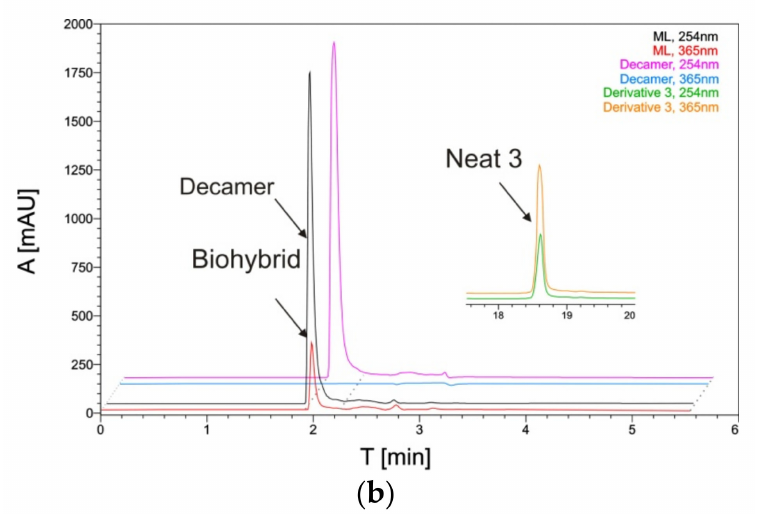
Figure 6. ( a ) The part of the DOSY spectrum of a 1:1 molar ratio of 1 and 3 in D2O buffer, pH 6, 25 ◦ C in the mother liquor (ML) after filtration of the reaction mixture (Figure S6b). The diffusion coefficient Di, 1.0 ± 0.1 × 10 -10 (m 2 s -1 ) is equal for both components; ( b ) the part of the HPLC chromatogram run for the mother liquor as in DOSY, compared with neat decamer. The run monitored by 365 nm shows the same retention time of the compound bound to DNA. The inset shows the retention time for free compound 3